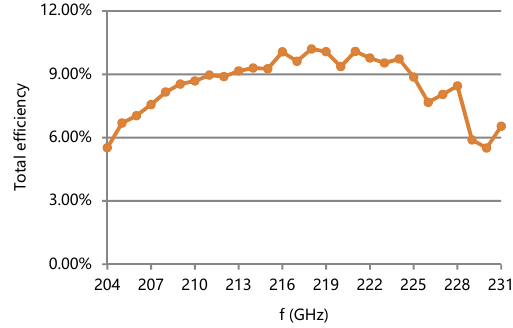
Figure 20. Measured total efficiency of the TWT. Figure 21 is the photo of the packaged G-band TWT. The weight of the packaged TWT is 2.5 kg and the size is 330 mm × 70 mm × 70 mm, respectively.